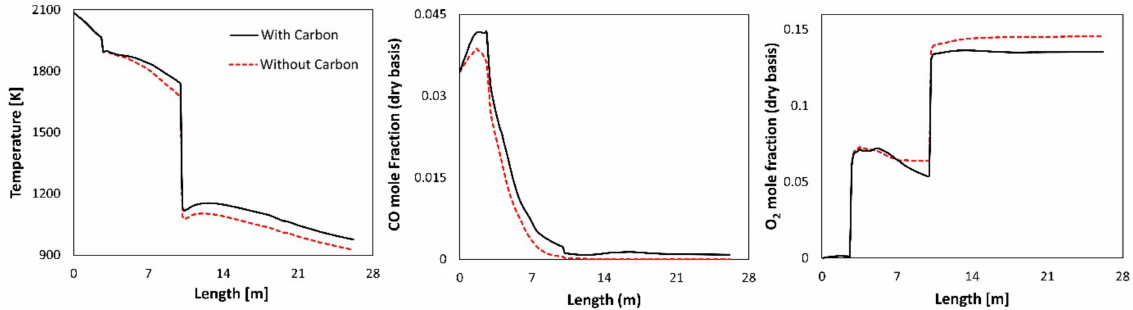
Figure 13. Effect of gas–solid (carbon) reaction on averaged cross-section composition and tempera- ture profiles of the off-gas [76].